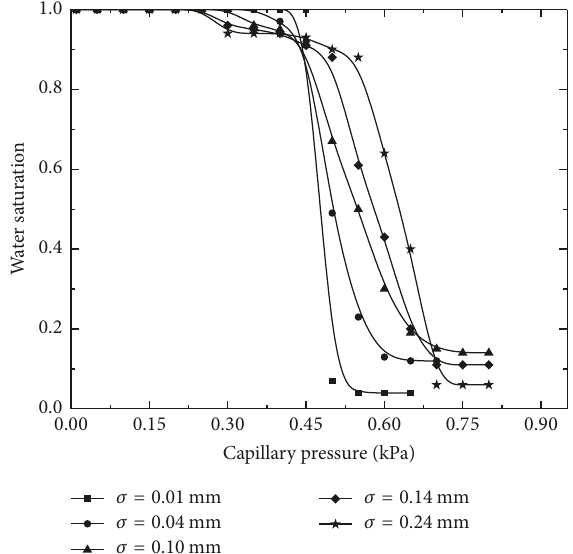
Figure 11: Capillary pressure-saturation curves for fractures with different standard deviations.